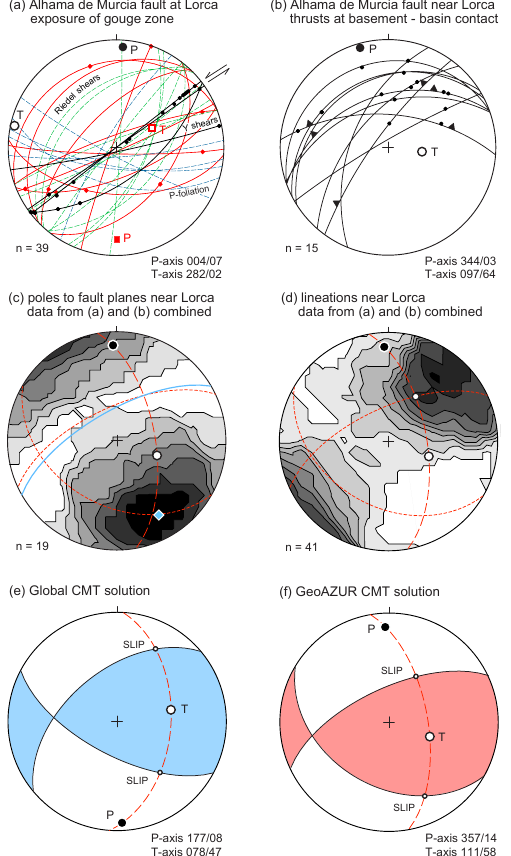
Fig. 2. Stereographic projections (equal area, lower hemisphere) showing orientations of faults and lineations in outcrops of the Al- hama de Murcia fault near Lorca, from locations a and b indicated in Fig. 1, and focal mechanisms of the Lorca earthquake. (a) Struc- tural data from fault gouge outcrop of location a near Lorca, after Meijninger and Vissers (2006). P and T axes denote the principal axes of incremental shortening and extension inferred from fault plane orientation, lineations on the fault plane and slip direction fol- lowing Marrett and Allmendinger (1990). Data in red are striated fault planes, with related P and T axes in red. (b) Structural data from faulted basement-basin contact of location b about 5km east- northeast from Lorca, after Meijninger and Vissers (2006), with P and T axes as in (a) inferred from structural data. (c) Poles to fault planes from (a) and (b) contoured at 1 σ intervals using Kamb contouring. Diamond indicates average pole, greatcircle in blue is the corresponding average fault orientation. Dashed lines represent fault plane solution shown in (f) , with P and T axes inferred from seismology. Note consistency of the average fault orientation with the NE striking nodal plane. (d) Lineations on fault planes com- bined from (a) and (b) , contoured using 1 σ interval Kamb contour- ing. Dashed lines as in (c) denote CMT solution. Note consis- tency of the maximum density with the expected slip direction from the CMT solution (small white dot). (e) Global centroid-moment- tensor (CMT) solution from the Global CMT Project. Dashed great- circle representing plane through P and T intersects nodal planes along directions of expected slip. (f) GeoAZUR centroid-moment- tensor (CMT) solution, dashed greatcircle as in (e) to show expected slip